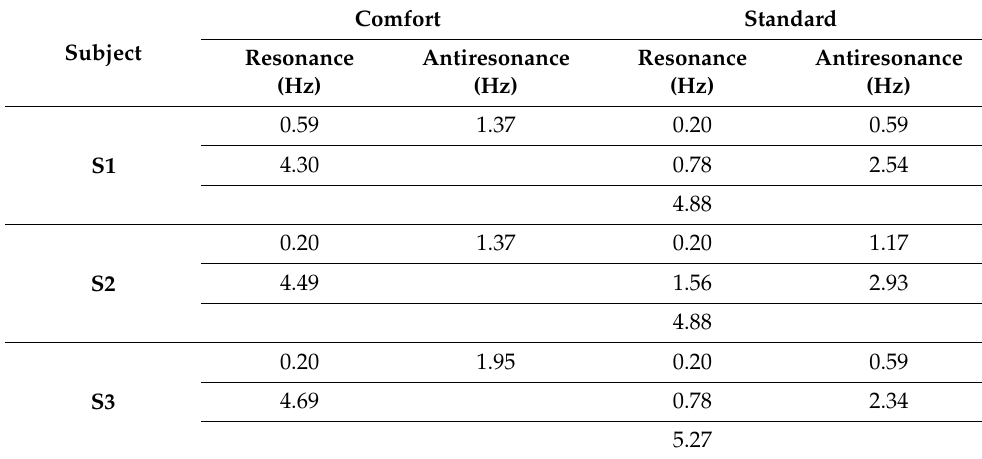
Table 3. Main resonance and antiresonance frequency values for comfort and standard seats of Intercity trains.